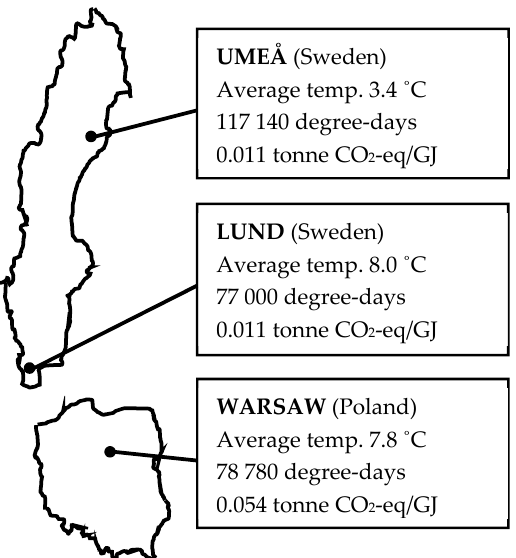
Figure 3. Three geographical sites in Europe, Umeå and Lund in Sweden and Warsaw in Poland were used in order to study the influence of climate and heat source on ROI Energy/GHGe and AY Energy/GHGe . The degree-days has been calculated for an indoor heating requirement of 17 °C. The remaining heat requirement is assumed to be covered by internal loads.